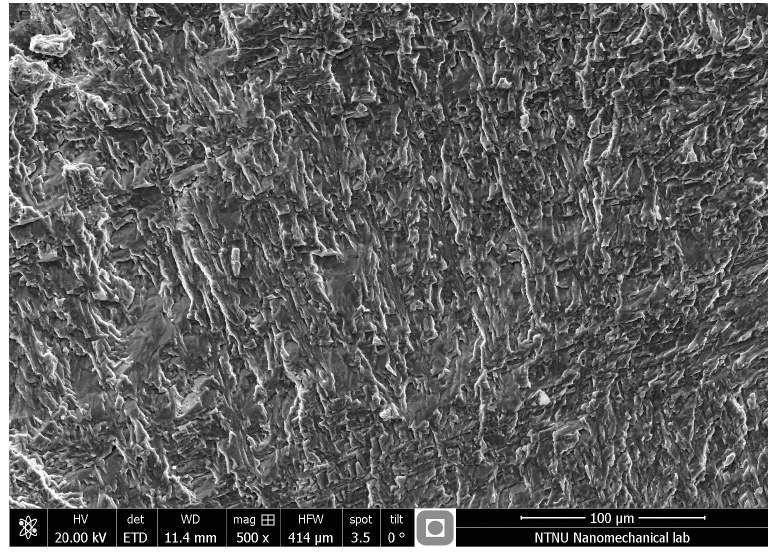
Figure 6. Fracture surface from a LENS non-porous flat specimen under uniaxial loading.